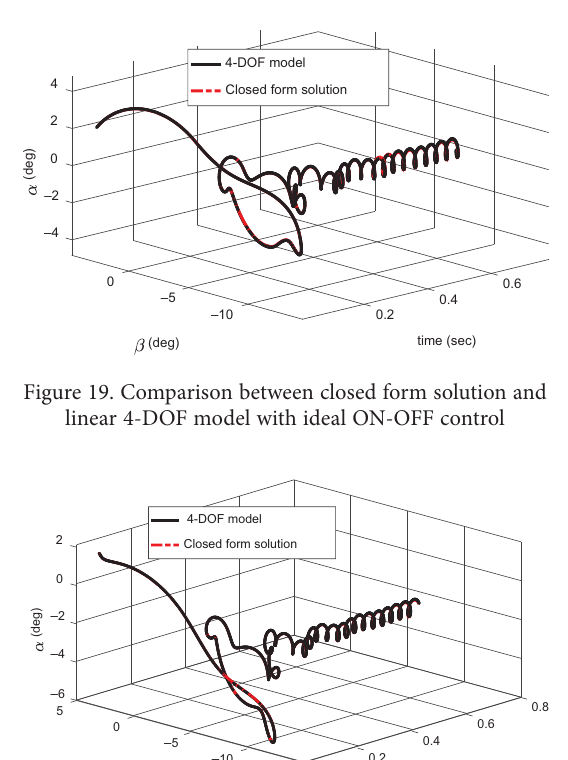
Figure 18. Effect of roll rate changing on real ON-OFF controlled rolling airframe